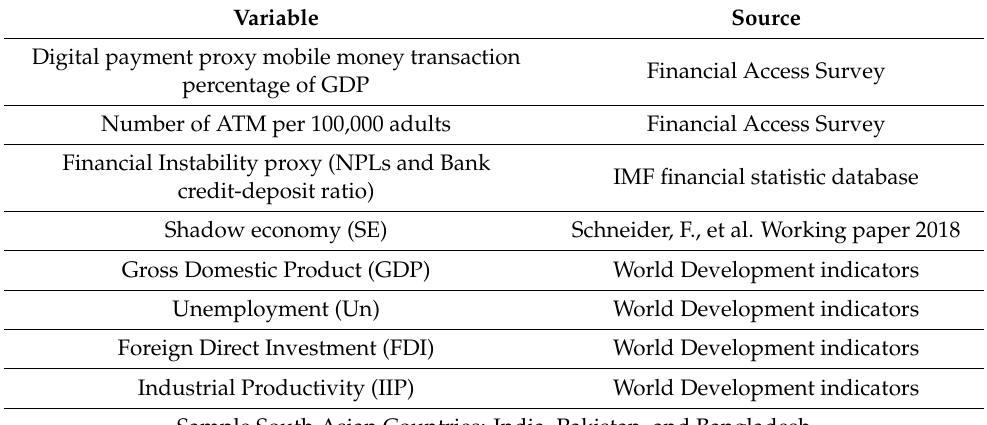
Table 1. Variables’ description and data